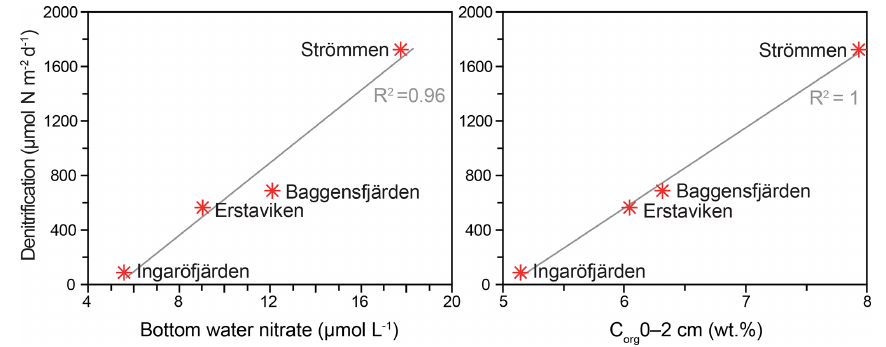
Figure 9. Relationship between denitrification and bottom water NO − the other for the study sites in the Stockholm archipelago.